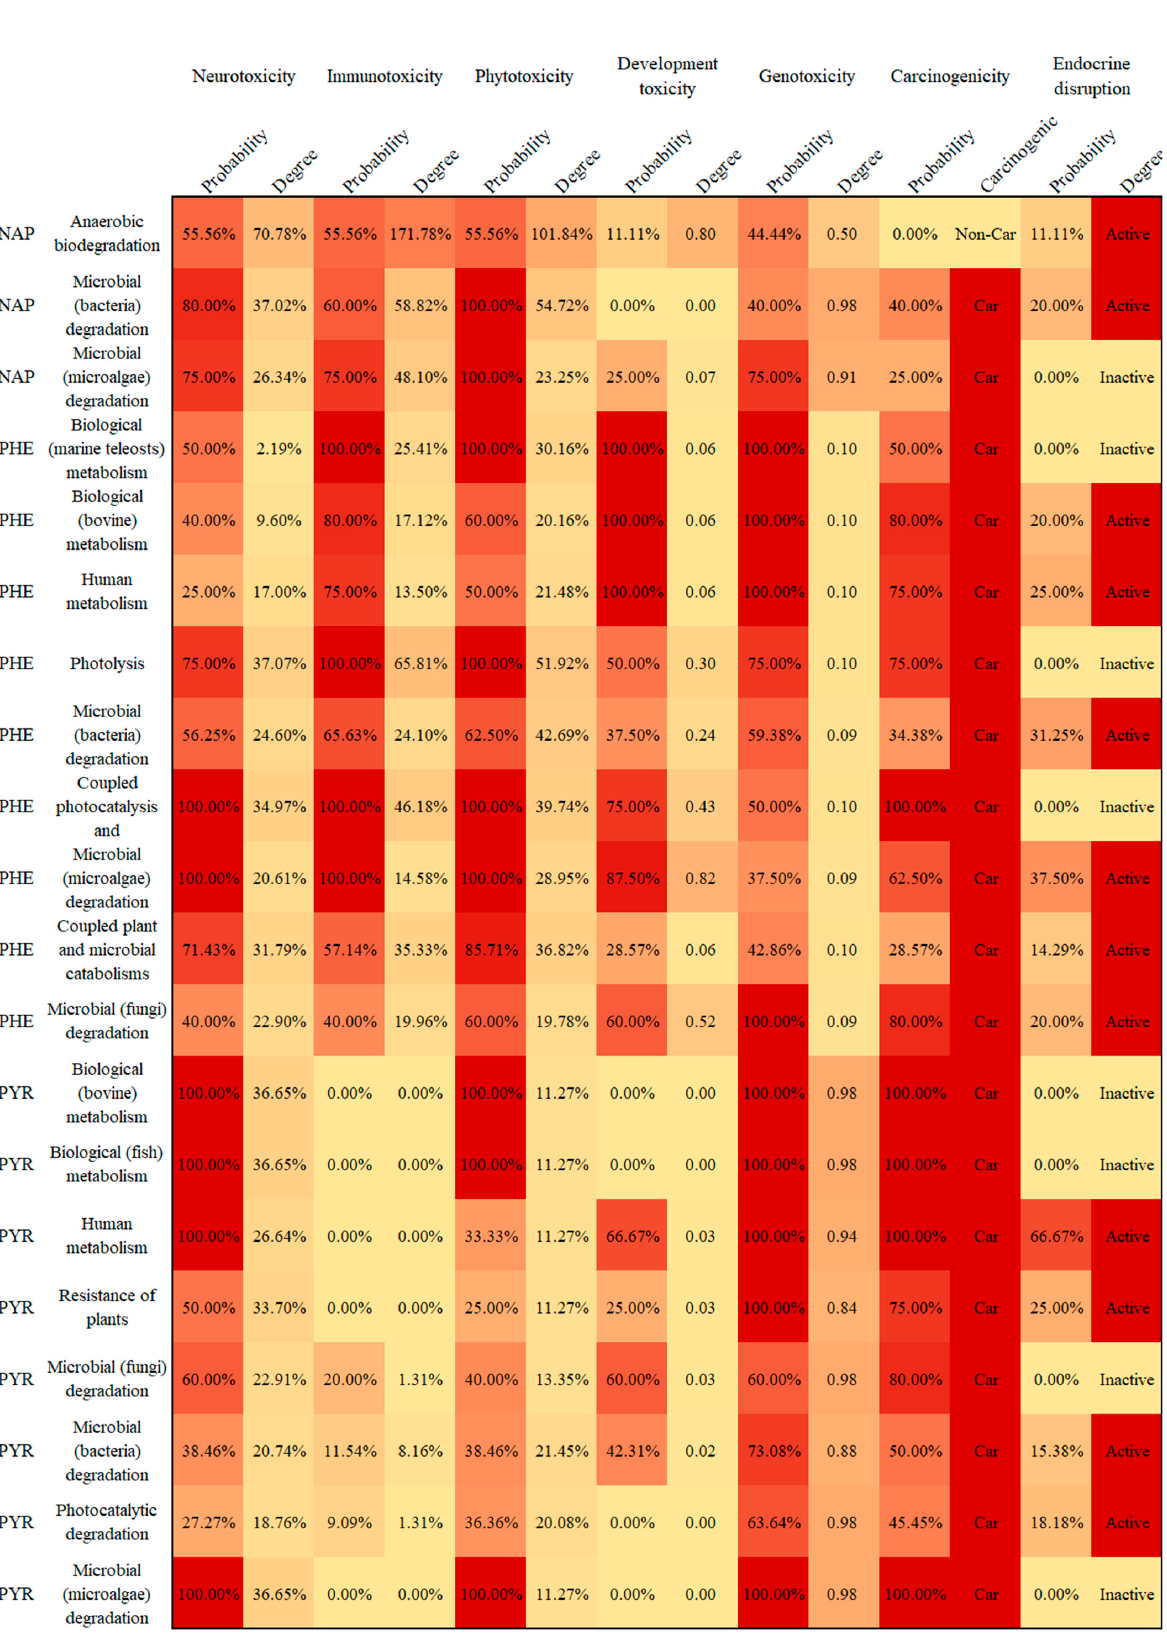
Figure 2. Risk diagram of biological metabolism and environmental transformation of 16 PAHs. (The intensity of the color indicates the enhanced intensity of toxicity risk probability or degree (The enhanced intensity of reduced toxicity reduction was regarded as